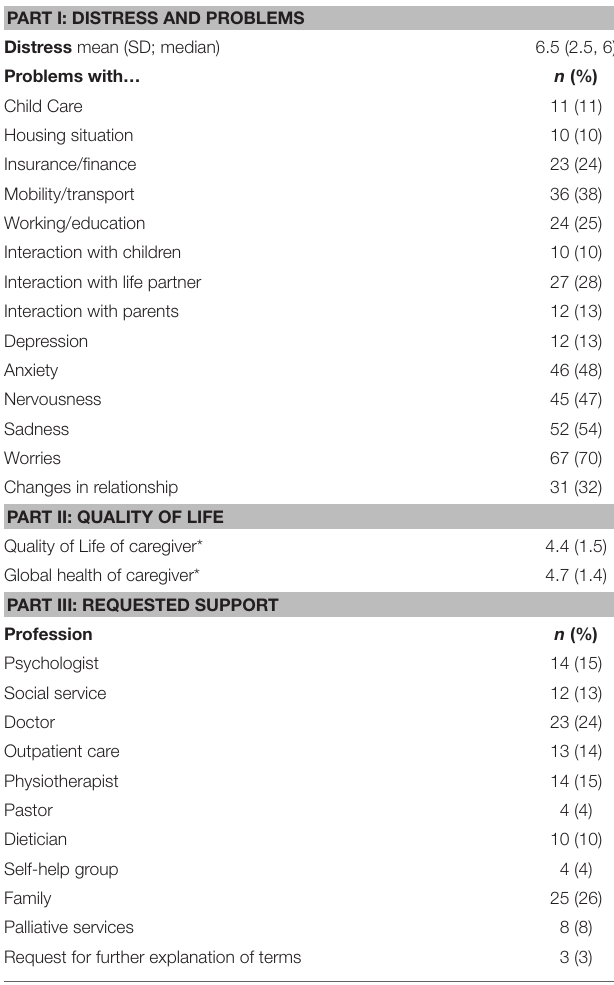
TABLE 3 | Results of assessments in 96 caregivers using the self-developed questionnaire. PART I: DISTRESS AND